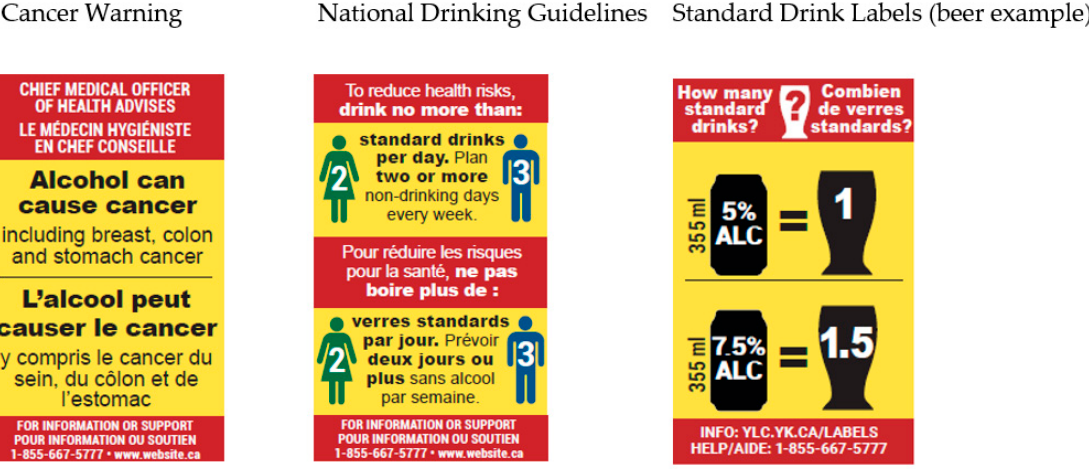
Figure 1. Warning labels trialled in the Yukon Territory, Canada.